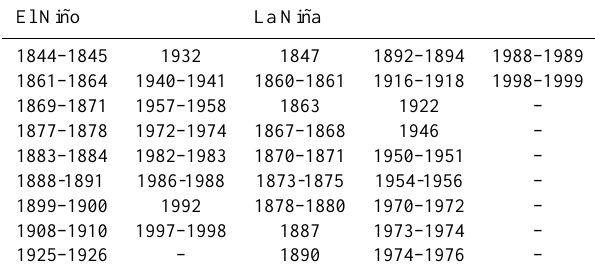
Table 1. List of strong, very strong, and extended El Ni˜no and La Ni˜na events included in core MUC-1B chronology. The El Ni˜no historical events before AD 1950 are taken from Quinn et al. (1987), Quinn (1992), Garcia-Herrera et al. (2008), and Gergis and Fowler (2009). La Ni˜na events correspond to those reported by Gergis and Fowler (2009). After AD 1950, ENSO events correspond to events longer than or equal to 12 months (Trenberth,